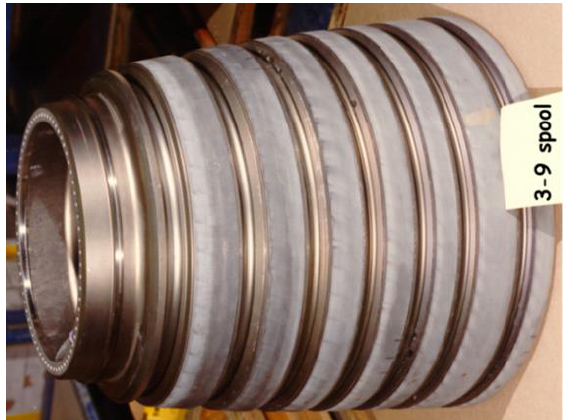
Figure 6. A seven stage one piece compressor spool for a 747 class engine. The front five stages are Ti-6-4 and the last two stages are Ti-6242 [2].